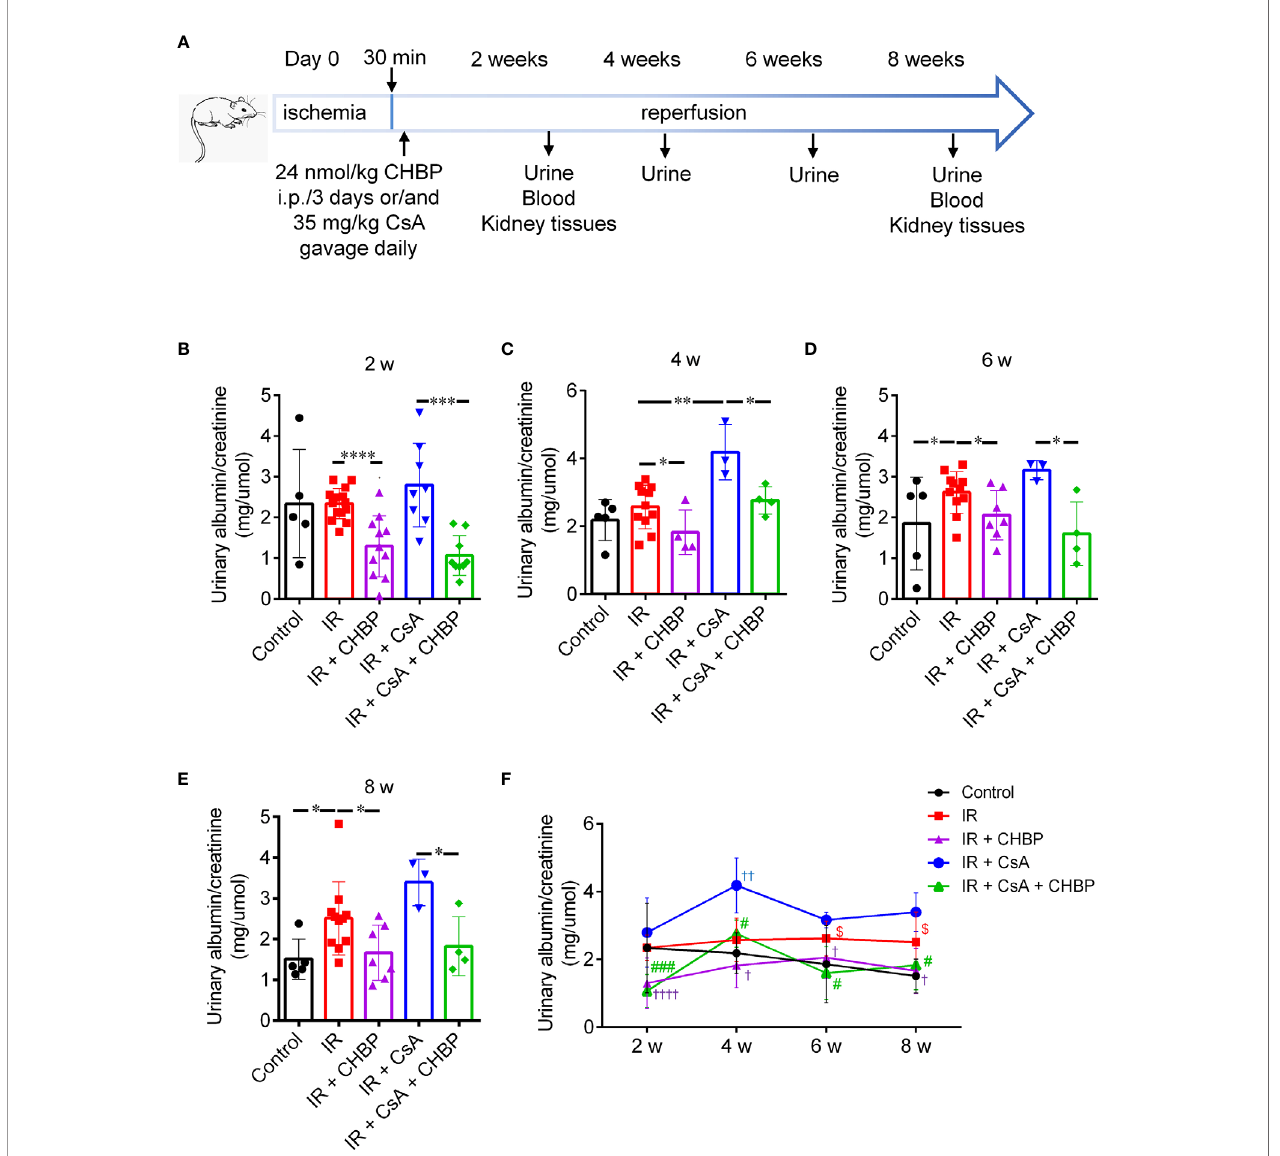
FIGURE 1 | Schematic picture of in vivo study design and urinary albumin/creatinine. (A) Bilateral renal pedicles were clamped for 30 min followed by reperfusion for 2 and 8 weeks. Approximately 35 mg/kg CsA gavage daily, and/or 24 nmol/kg CHBP intraperitoneal injection every 3 days. Urine samples were collected every 2 weeks, blood samples were drawn and animals were sacri fi ced at 2 and 8 weeks. (B – E) The ratio of urinary albumin/creatinine was shown in the IR group with/ without CsA treatment at 2, 4, 6 and 8 weeks. * P ≤ 0.05, ** P ≤ 0.01, *** P ≤ 0.001, **** P ≤ 0.0001. (F) The dynamic pro fi le of urinary albumin/creatinine at all-time points. † P < 0.05, †† P ≤ 0.01, †††† P ≤ 0.0001 versus IR; # P < 0.05, ### P ≤ 0.0005 versus IR + CsA and $ P < 0.05 versus the control. Data were expressed as the mean ± SD of each group (n ≥